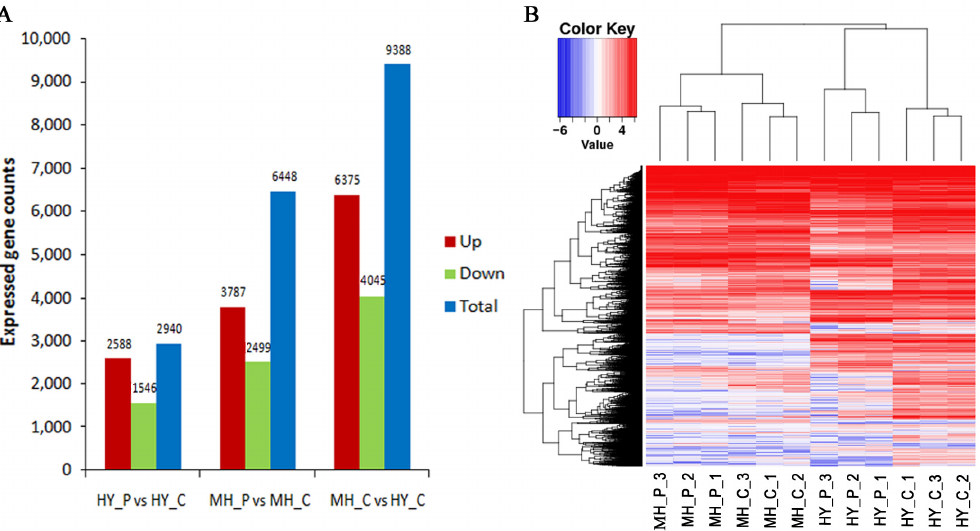
Figure 2. The number of the DEGs identified ( A ) and heat map ( B ) for MH and HY with Psa.